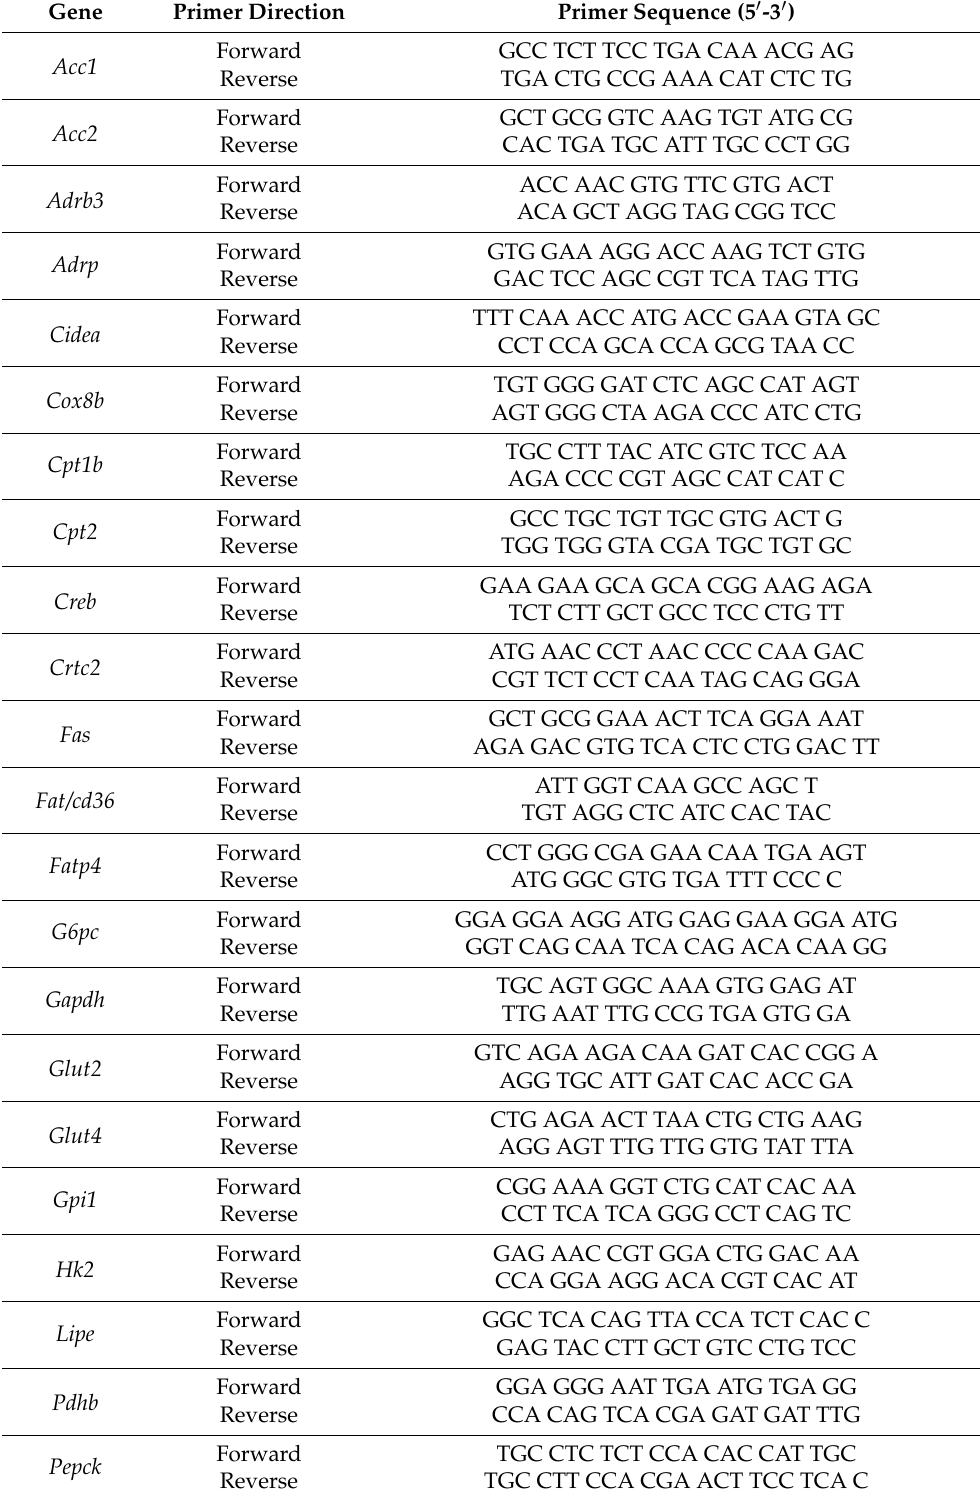
Table 2. Primer sequences of genes used for real-time